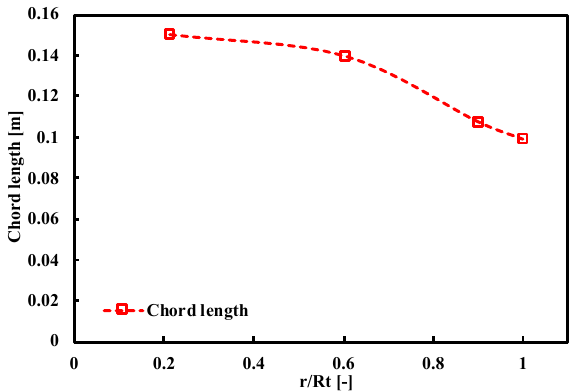
Figure 3. Chord length distribution along the blade span.